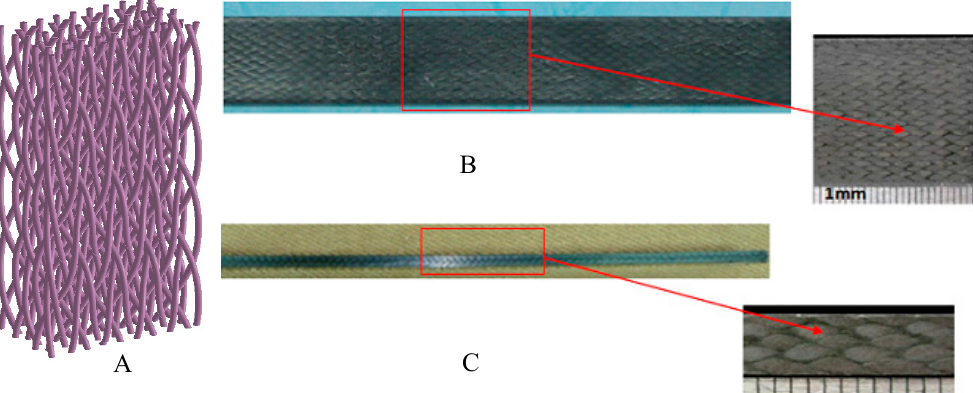
Figure 1. Three-dimensional four-directional carbon fiber braided composites: ( A ) Structural sketch of internal reinforcement; ( B ) Surface morphology of carbon fiber braided composites; ( C ) Side morphology of carbon fiber braided composites.